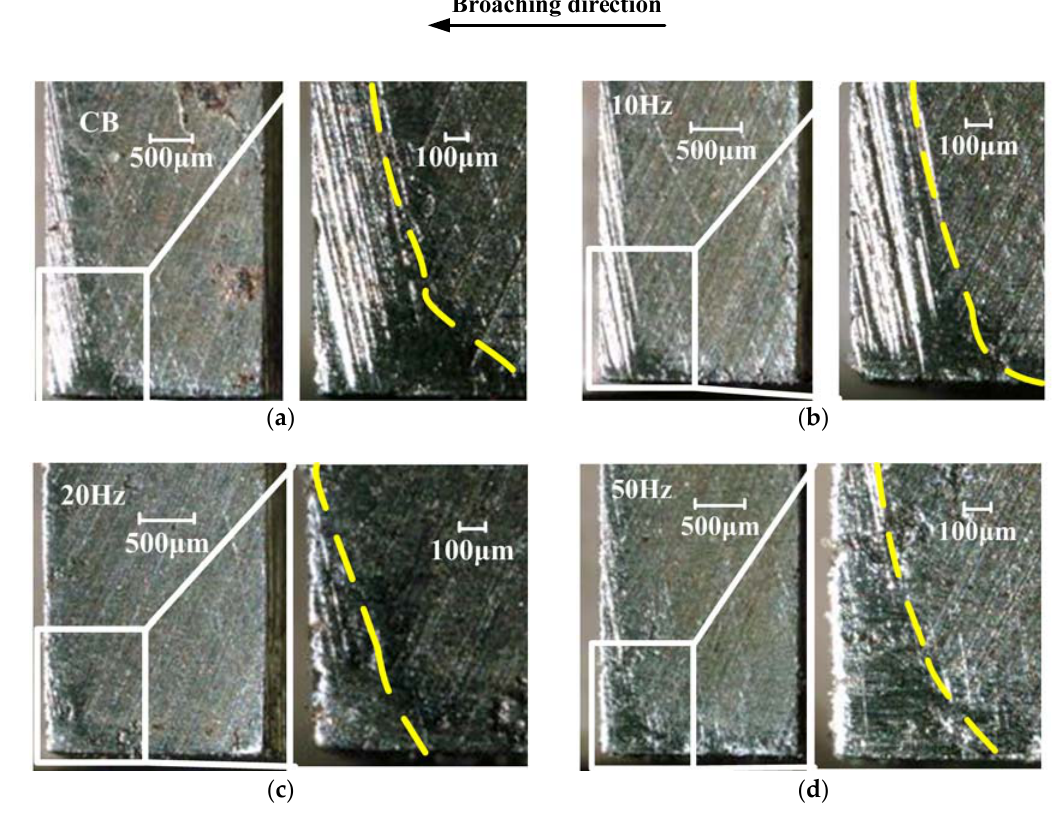
Figure 11. Tool wear of ( a ) CB, ( b ) 10 Hz, ( c ) 20 Hz and ( d ) 50 Hz.